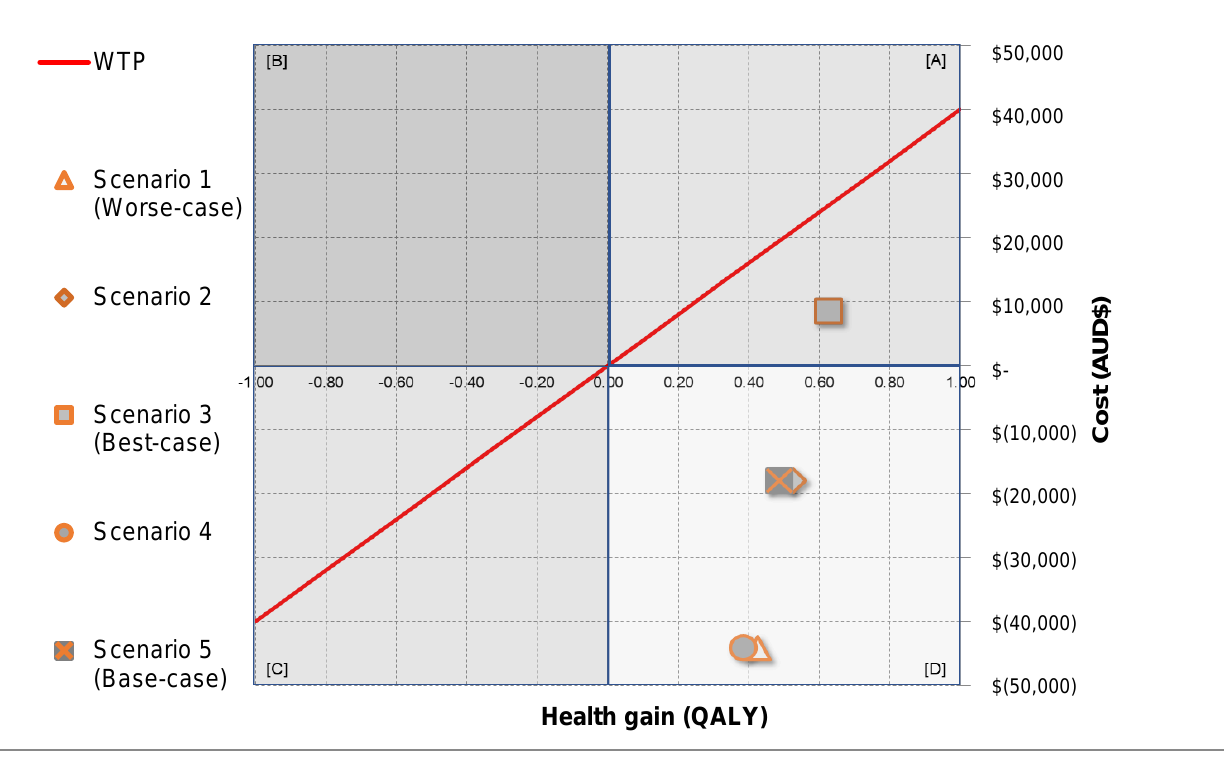
Figure 3: Cost-utility analysis showing incremental cost-utility ratio (ICUR) including the indicative ICUR of -$36,890 per quality-adjusted life- year (QALY) for the best-case and willingness-to-pay threshold (WTP) of $40,000 per QALY for the provision transfemoral socket-suspended prostheses attached to residuum without and with distal weight bearing Keep Walking Implant (KWI) including quadrants indicating that provision with the KWI was more costly and more effective (Quadrant A: Consider ICUR), more costly and less effective (Quadrant B: Dominated), less costly and less effective (Quadrant C: Consider ICUR), less costly and more effective (Quadrant D: Dominant) than usual